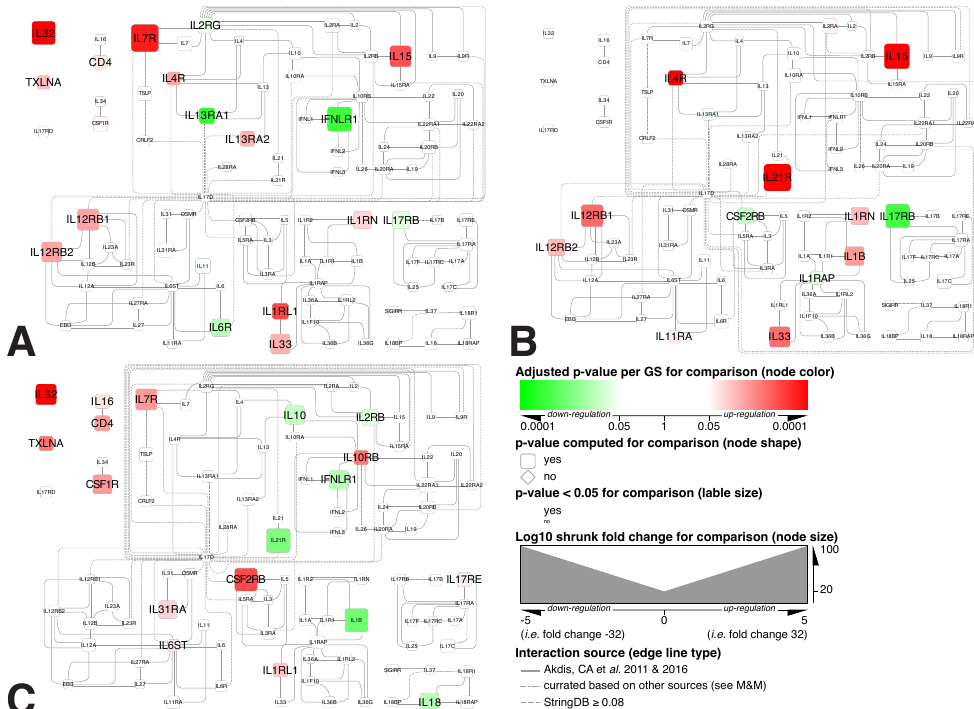
Figure 6. Alterations in interleukins-interferons ligand/receptor gene expression visualized within a curated interactome. ( A ) MCD vs. N_CTRL, ( B ) MCD vs. MN [33,34] and ( C ) MN vs. N_CTRL. The specific methodology used to construct this interactome is outlined in Section 2. The legend applies to all 3